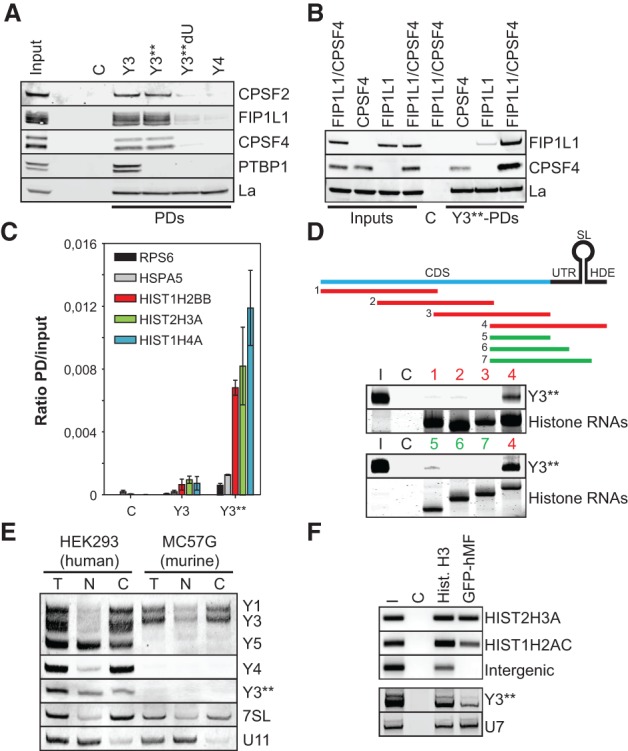
Y3** associates with the 3′ UTR of histone pre-mRNAs. (A) The copurification of proteins with the indicated Y RNAs, as in Figure 1C, was analyzed by Western blotting with the indicated antibodies. (C) Bead control; (I) input fraction (5% of total). (B) HEK293 cells were transfected with FIP1L1 and/or CPSF4 for 48 h as indicated. The pull-down (PD) of proteins with Y3**, as in Figure 1C, was analyzed by Western blotting. (C) Bead control; (I) input fractions (5% of total). (C) The copurification of the indicated mRNAs with biotinylated Y3 or Y3** was analyzed by RT-qPCR. The ratios of mRNA levels (pull-down/input) were determined by the ΔCT method. Streptavidin resin served as a negative control (C). Error bars indicate the SD of at least three independent analyses. (D, top panel) Biotinylated H3A-derived transcripts used as bait for the copurification of Atto680-labeled Y3** in pull-down studies are depicted relative to the full-length H3A histone pre-mRNA using color coding. Copurification of Atto680-labeled Y3** and pull-down of biotinylated histone transcripts were monitored by infrared scanning (Y3**) or Syto60 staining (histone RNAs) of TBE-urea gels, respectively. Streptavidin resin (C) served as negative control. (I) Input (2% of total). (E) Subcellular localization of the indicated ncRNAs was analyzed by cell fractionation and Northern blotting of total (T), nuclear (N), or cytoplasmic (C) RNA isolated from human HEK293 or murine MC57G cells. U11 and 7SL served as controls for the enrichment of nuclear or cytoplasmic RNAs, respectively. (F) Chromatin immunoprecipitation (ChIP) analyses were performed in HEK293 stably expressing GFP-tagged human Mini-Flash (GFP-hMF). Beads only (C) served as a negative control, and Histone H3 served as a positive control. (Top panel) Eluted DNAs were PCR-amplified (HIST2H3A, HIST1H2AC, and intergenic DNA) and analyzed together with the input (I) on agarose gels. (Bottom panel) Coprecipitated RNAs were subjected to 3′-RACE, PCR-amplified, and analyzed by Southern blotting using the indicated probes.